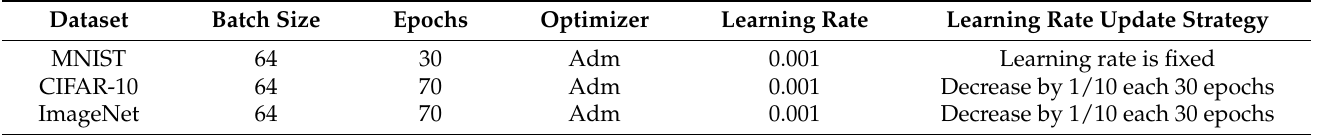
Table 2. Hyperparameter settings of